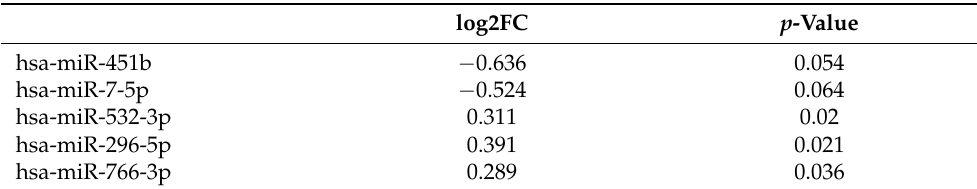
Table 4. List of replicated up and downregulated miRNAs without exacerbations and those experi- encing severe exacerbators in COPDGene.